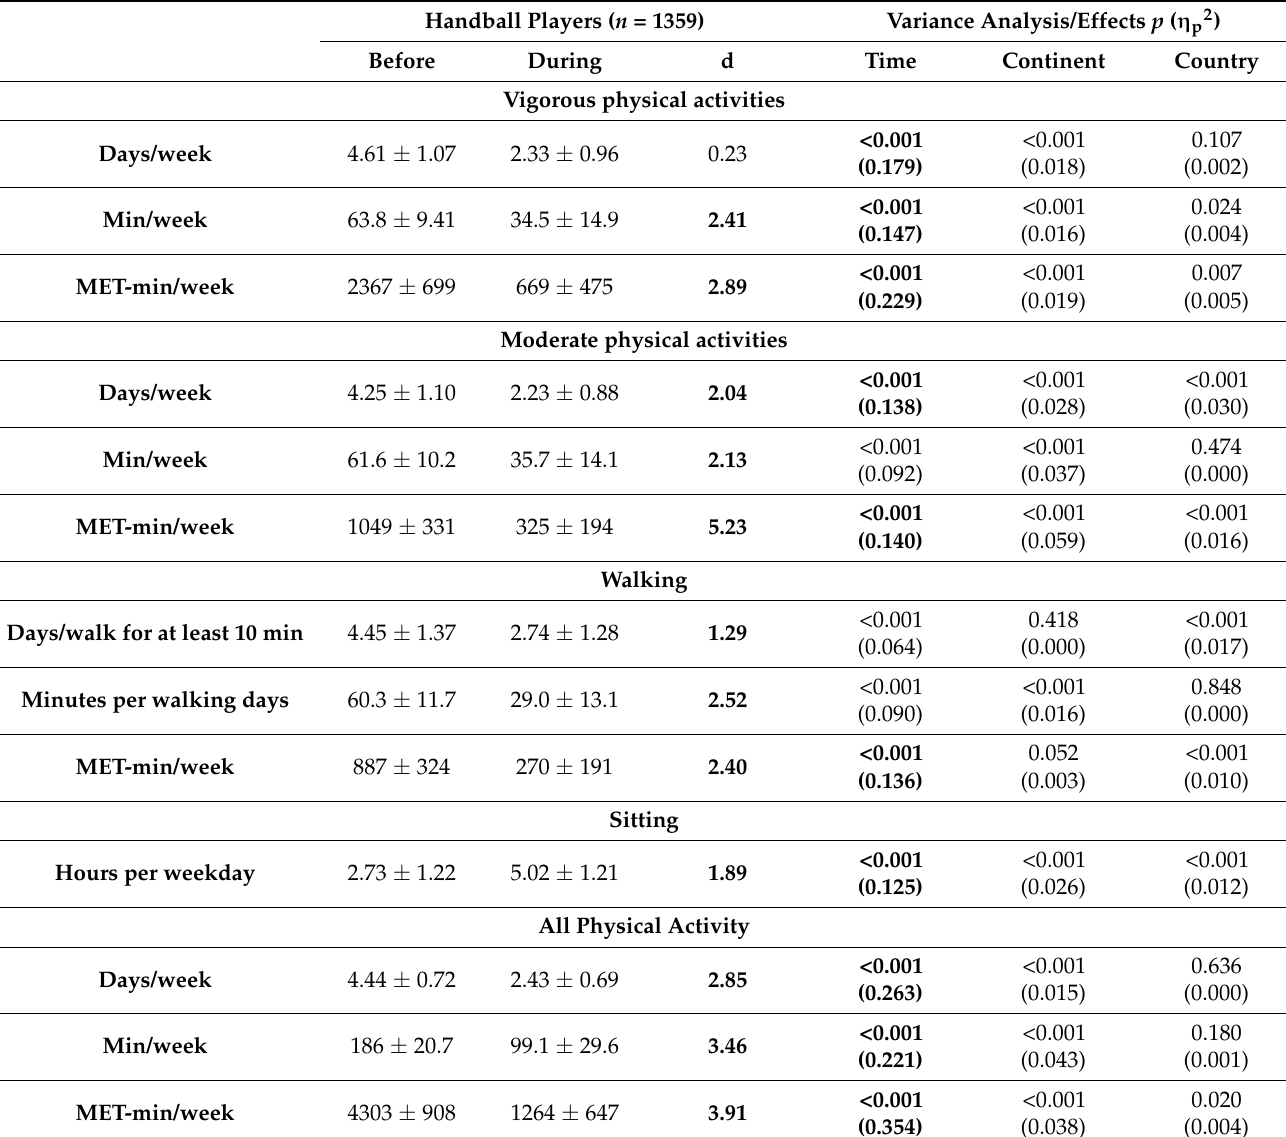
Table 5. Comparison of physical activity parameters before and during confinement (control variables: continent and country). Values are given as mean ± SD. Meaningful effects (criteria: p < 0.05 and η p2 > 0.10 and d > 0.8) highlighted in bold. MET = Metabolic Equivalent of Task. Handball Players ( n =